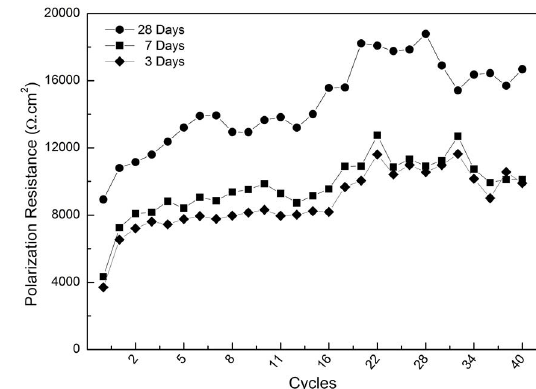
column graphs for 7 days. Figure 9. R p